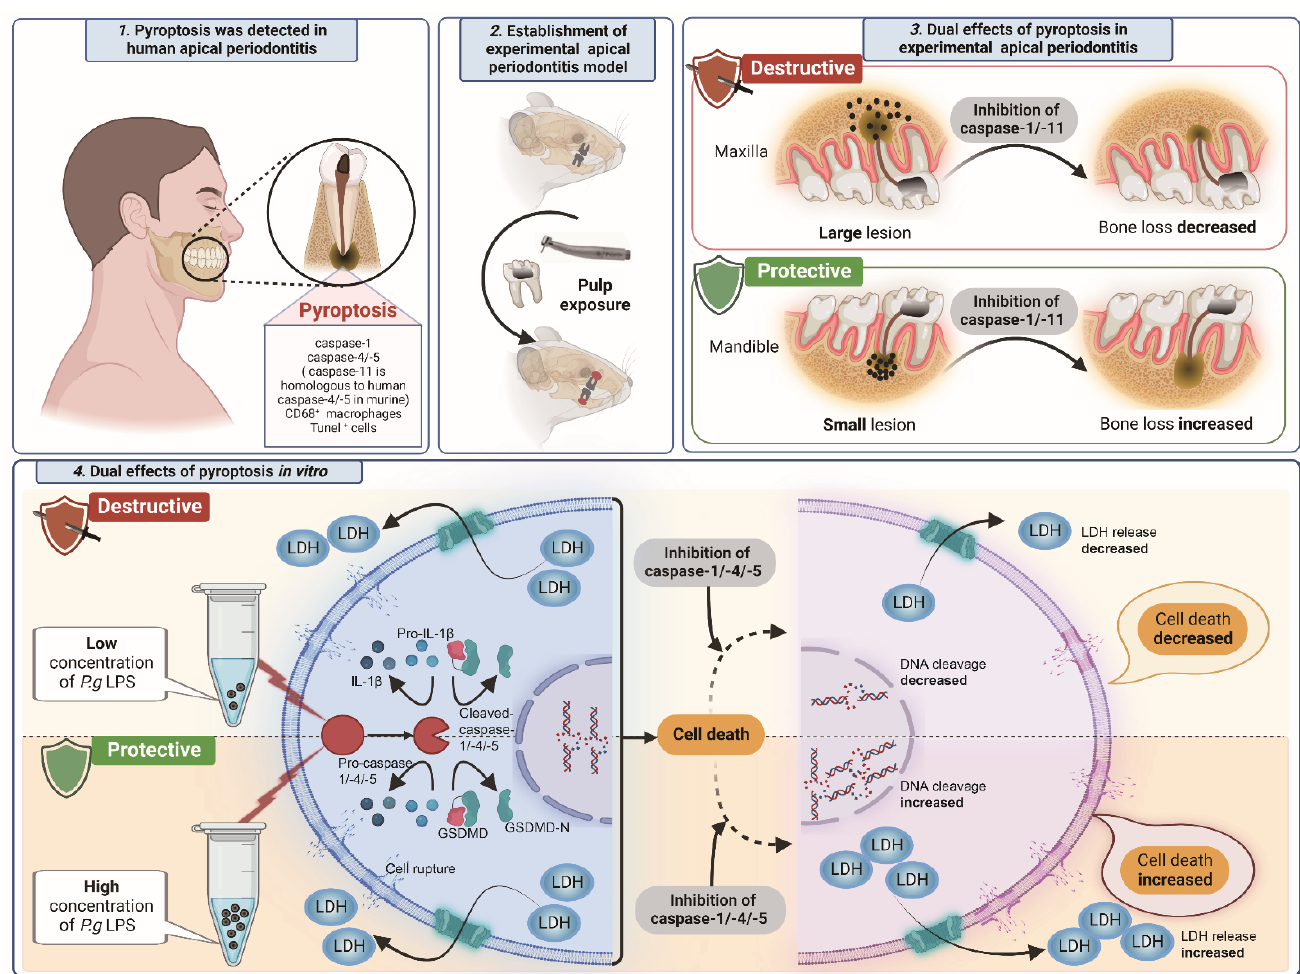
Figure 8. The schematic diagram of dual roles of pyroptosis in apical periodontitis. Supplementary Materials: The following supporting information can be downloaded at: https: apical lesion developed gradually; Figure S2: Different levels of pyroptosis were detected in human AP by using TUNEL staining and immunofluorescence; Figure S3: Pyroptosis was detected in EAP by using TUNEL staining and immunofluorescence Table S1: Proteins with significantly changed in abundance.; Table S2: Proteins that consistent presence/absence expression